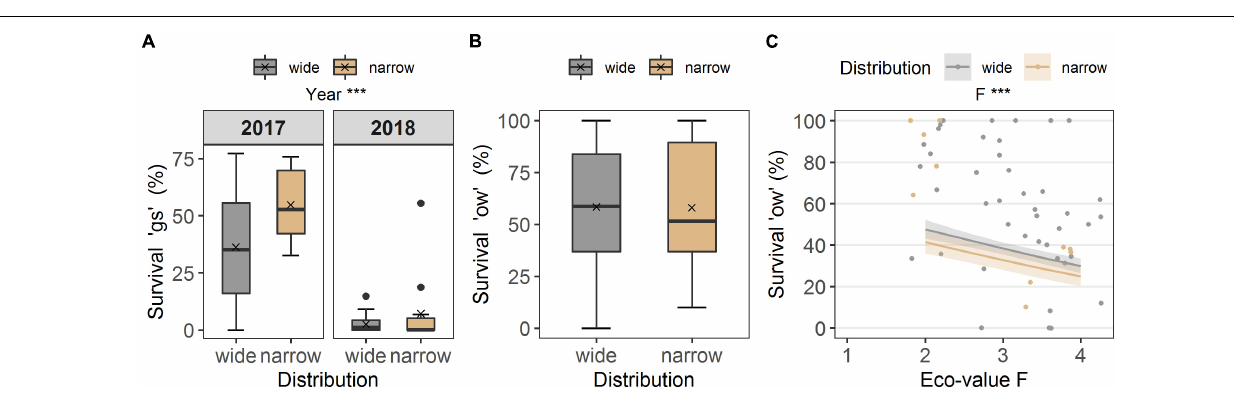
FIGURE 4 | (A) Seedling survival of the growing season (“gs”) in the common garden, grouped according to distribution (wide, narrow), for the years of observation (2017, 2018), and (B) overwinter seedling survival (“ow”). Boxes in (A) survival “gs” and (B) survival “ow” illustrate the interquartile range with the median as line; whiskers illustrate the minimum and maximum; points denote outliers; x denotes the mean. Points without boarder in (C) survival “ow” denote the observed values colored according to distribution along the ecological indicator value F (humidity), and colored ribbons denote confidence intervals from the model. Note different maxima on y -axis between panels. Stars denote significances at α = 0.001